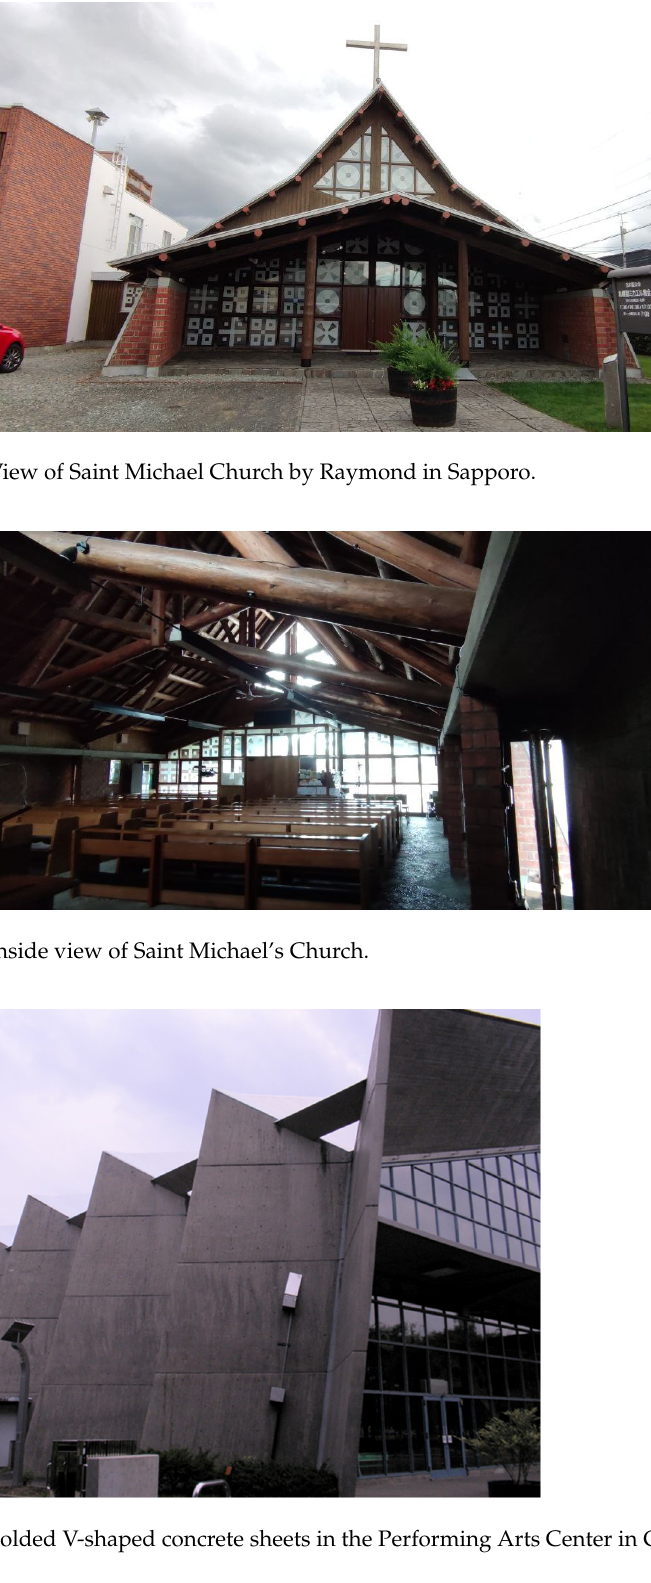
Figure 19. Parabolic forms in the Chapel of St. Paul at Rikkyo University, Japan. In a manner of speaking, we can see that Raymond was capable of deftly managing wind performance, ventilation, and solar exposure in and around his buildings as well as discarding processed materials in favor of reed, thatch, wood, and bamboo, as a surprising reaction to modern architectural demands. He showed a great deal of bioclimatic philos- ophy in doing so. 6. Conclusions Antonin Raymond produced a real advance in solar architecture due to his experi- ence and adequate management of compositional issues and in the wake of the accultura- tion that he had undergone. He achieved a long-sought-for attunement between Eastern and Western architectures, creating at the same time new kinds of building typologies. He understood perfectly what is nowadays termed “the forsaken Japan”, stemming from the long evolution of a singular tradition that experienced secular isolation, the sa- koku 鎖国, or “enchained” country. He realized its potential in the contemporary scene and felt at ease with its intelligent pursuit in search of a distinguished place in the inter- national scene. On this matter, Antonin Raymond argued: “An architect working in Japan has at his disposal the basic principles, whose re-discovery lies at the essence of modern architectural trends” [2] (p. 150). In truth, he dealt with a sophisticated, complex, and re- fined culture, which stayed apart from all other civilizations in the self-enclosing move- ment of sakoku (see above), in open defiance of the common and more fashionable prin- ciples, as became manifest in many realizations.